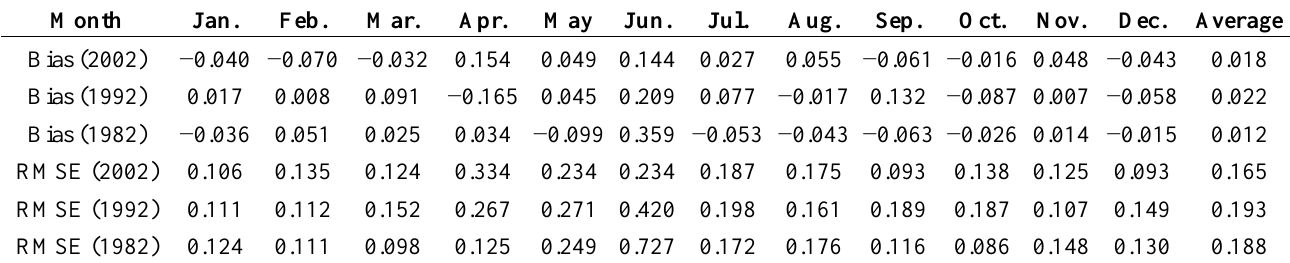
Table 6. Validations of sea ice concentration in 2002, 1992, and 1982 using the OLS regression models. The values for the entire pixels were aggregated.